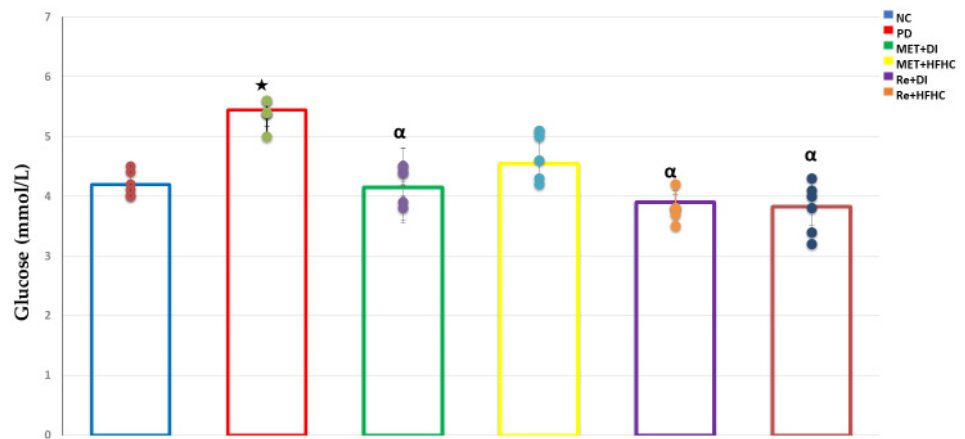
Figure 2. Fasting blood glucose in NC, PD, MET + DI, MET + HFHC, Re + DI and Re + HFHC at 12 weeks of treatment. Values are presented as means ± SD ( n = 6). * p < 0.05 by comparison with NC, α p < 0.05 by comparison with PD, MET + DI, MET + HFHC, Re + DI and Re +